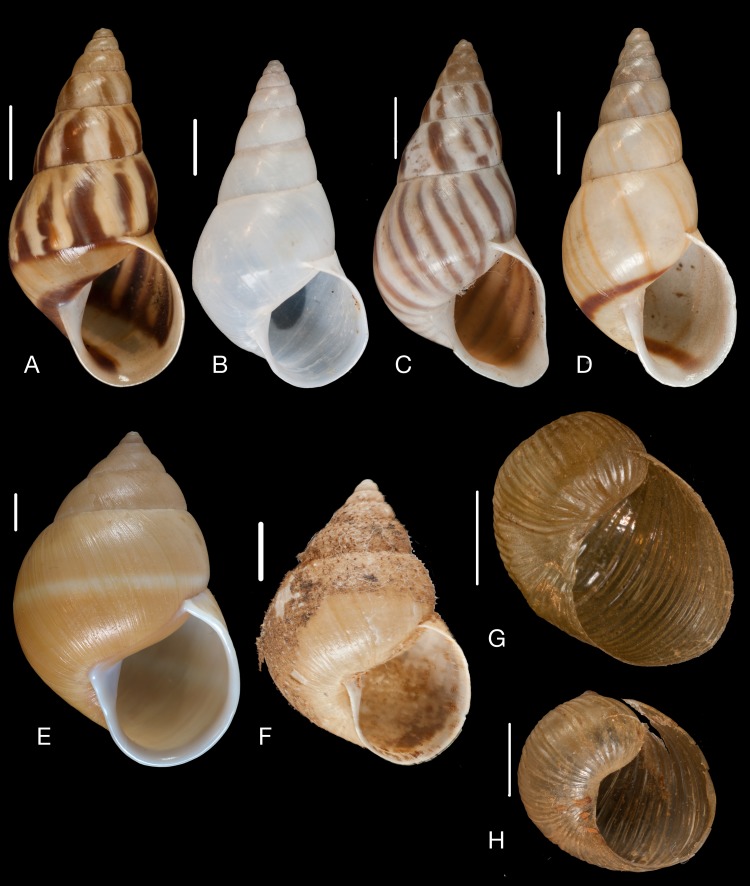
Material collected by the CCP.(A–H) Simpulopsidae. Leiostracus onager (Beck, 1837), MNCN 15.05/8135, (A) ventral view; Leiostracus perlucidus (Spix in Wagner, 1827), MNCN 15.05/13341, (B) ventral view; Leiostracus vimineus (Moricand, 1834), MNCN 15.05/12995, (C) ventral view; Leiostracus vittatus (Spix in Wagner, 1827), MNCN 15.05/20332, (D) ventral view; Rhinus heterotrichus (Moricand, 1836), MNCN 15.05/13485, (E) ventral view; Rhinus scobinatus (Wood, 1828), MNCN 15.05/8116, (F) ventral view; Simpulopsis rufovirens (Moricand, 1846), MNCN 15.05/20127, (G) ventral view;  Simpulopsis sulculosa (Férussac, 1822), MNCN 15.05/20126, (H) ventral view. Scale line 5 mm.